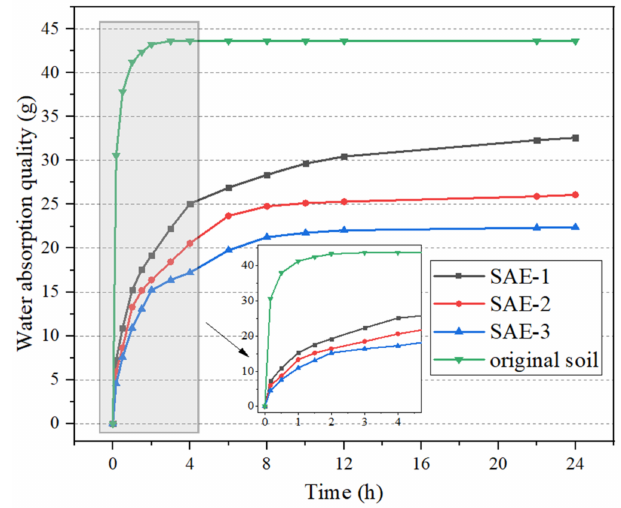
Figure 8. Group C capillary water absorption test results.